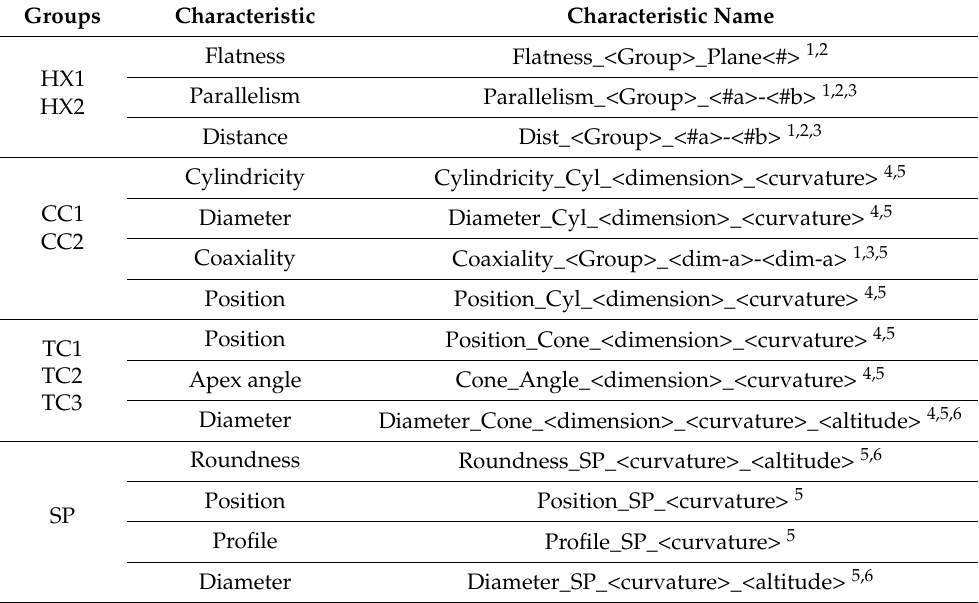
Table 5. Characteristics with accompanying naming